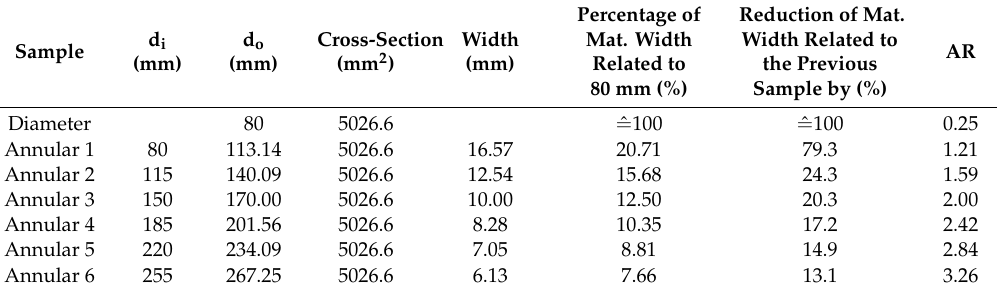
Table 2. Design of annular test samples consisting of 10 layers (h = 20 mm).